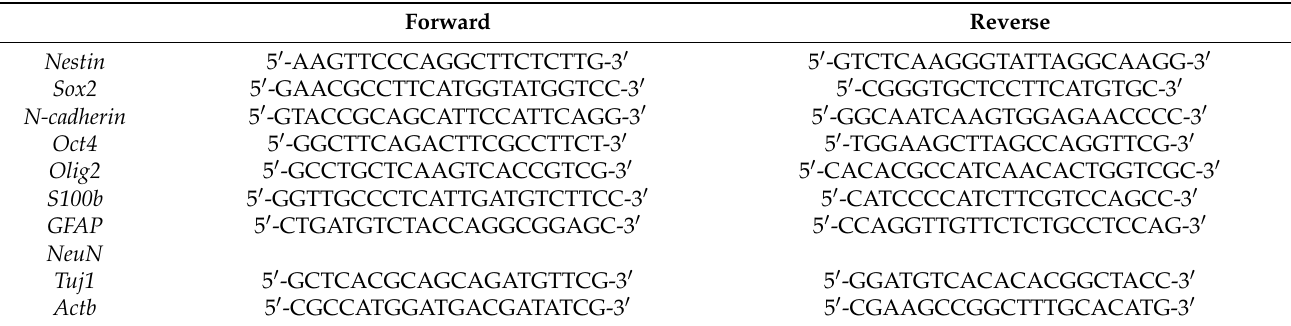
Table 1. Primer sets used for real-time